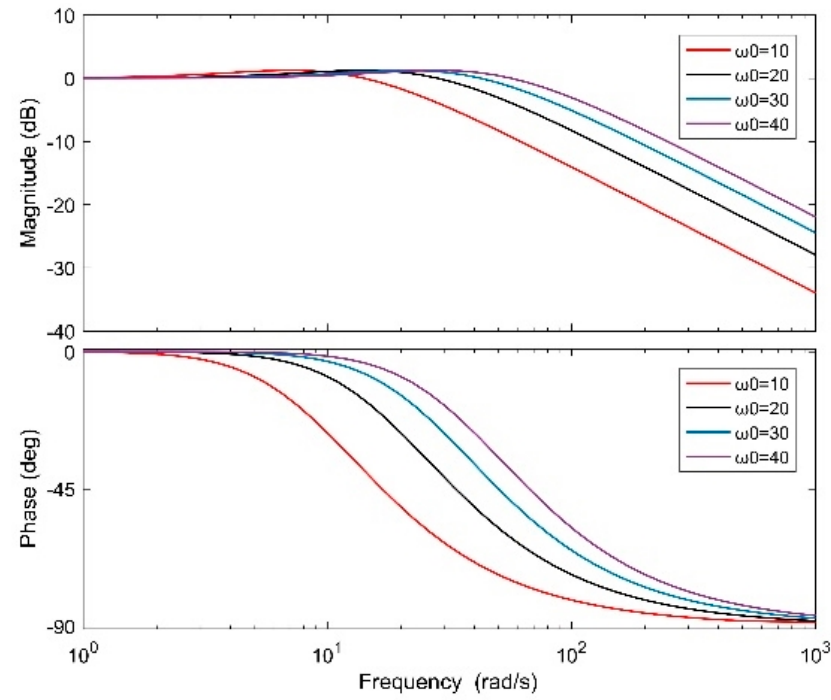
Figure 6. Frequency domain characteristics of output noise disturbance.